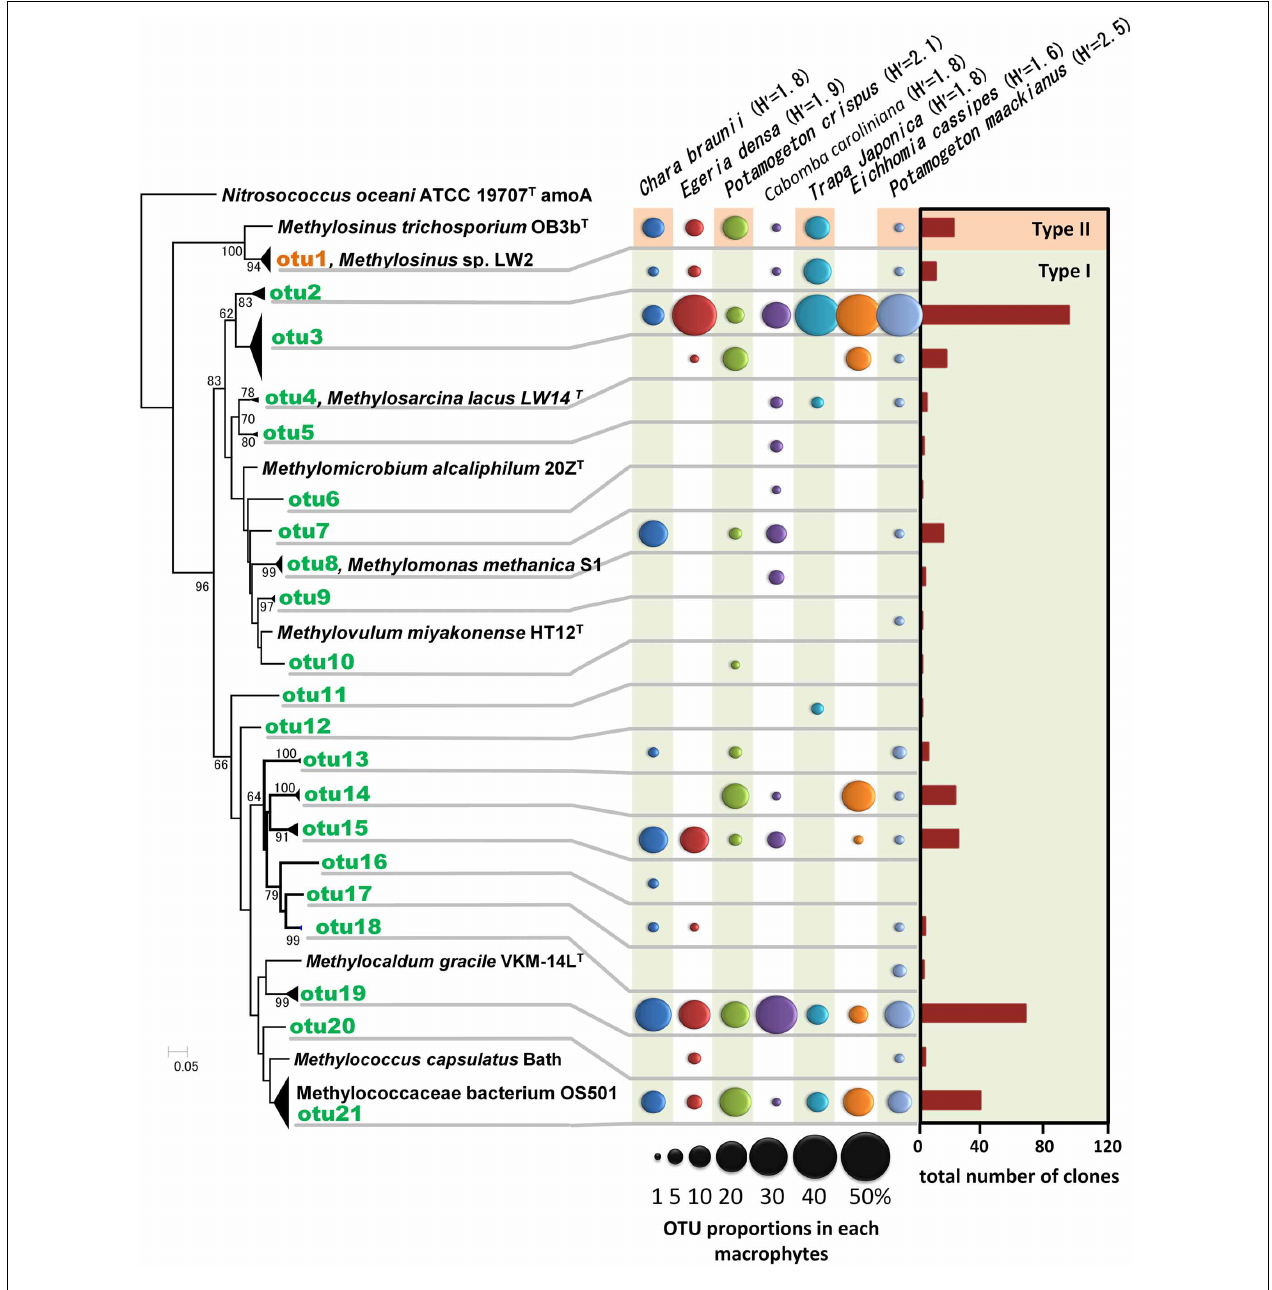
FIGURE 4 | Neighbor-joining tree of methanotrophic phylotypes detected in the aquatic plants based on the deduced amino acid sequences of pmoA genes. Sequence of amoA of Nitrosococcus oceani was used as an outgroup to root the tree. H’ values are Shannon diversity indices (Shannon and Weaver,